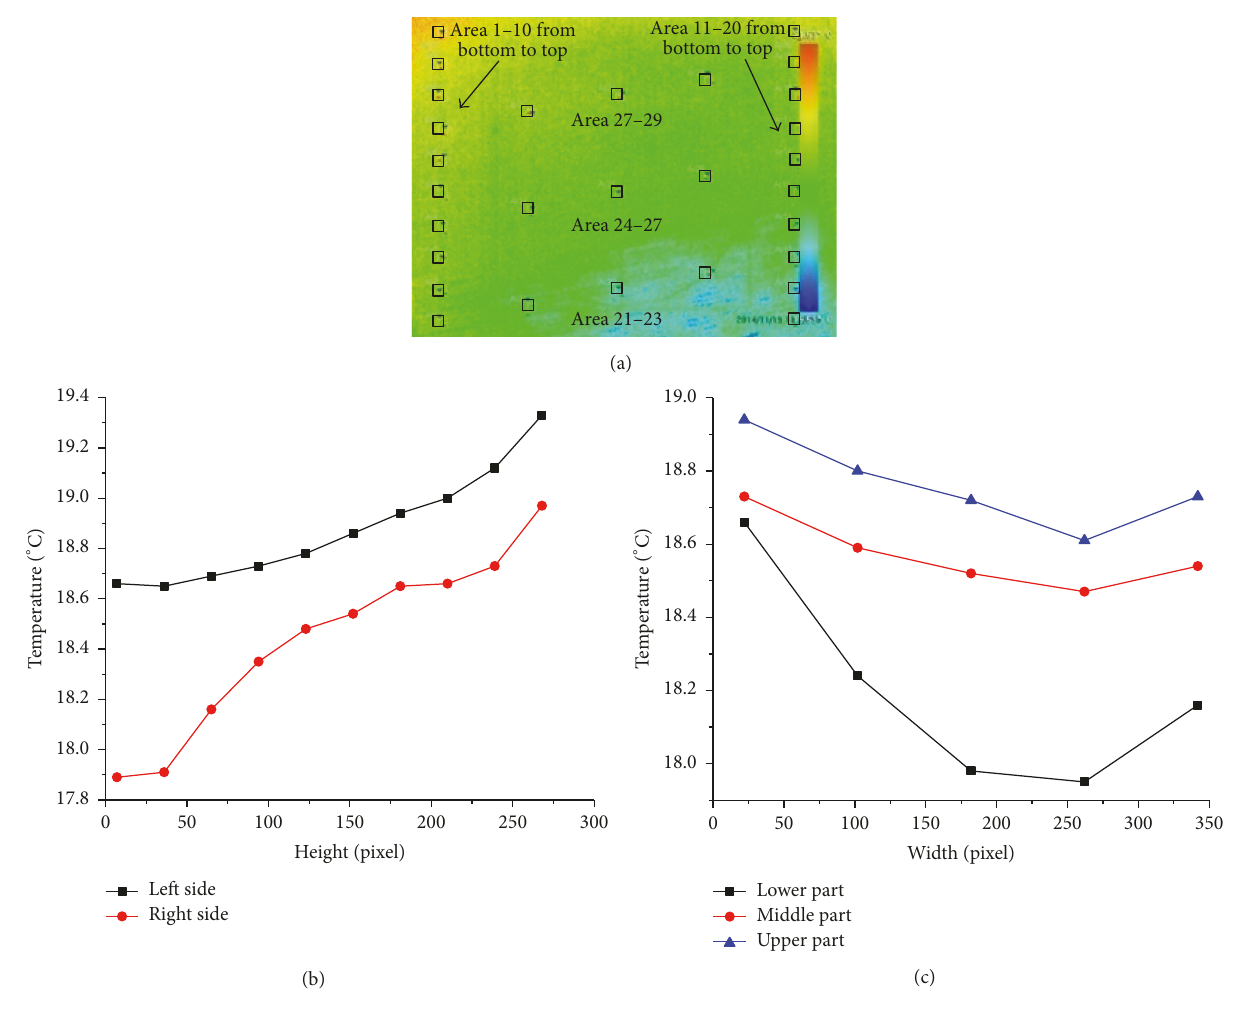
Figure 7: Diagrams of arrangement of the temperature ROIs and temperature distribution curves; (a) diagram of arrangement of the temperature ROIs on the infrared image before excavation; (b) diagram of temperature distributions from bottom to top of the model; and (c) diagram of temperature distributions from left to right of the model along the rock